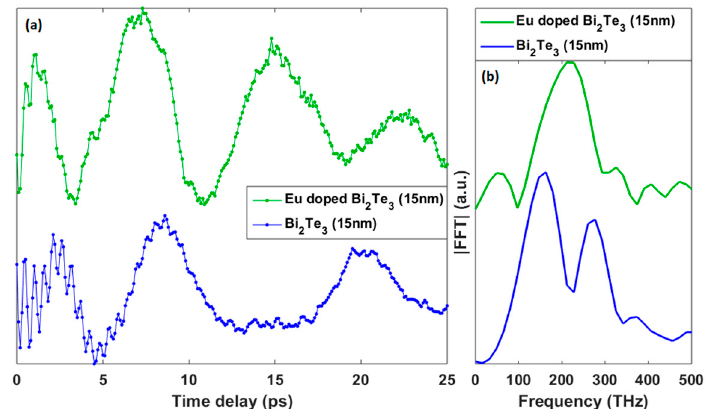
Figure 8. ( a ) Coherent acoustic phonon signals extracted from the transient optical reflectivity signals (see Figure 7a) for undoped and Eu doped Bi 2 Te 3 film. ( b ) Corresponding coherent acoustic phonon spectra obtained by a fast Fourier transform (FFT).